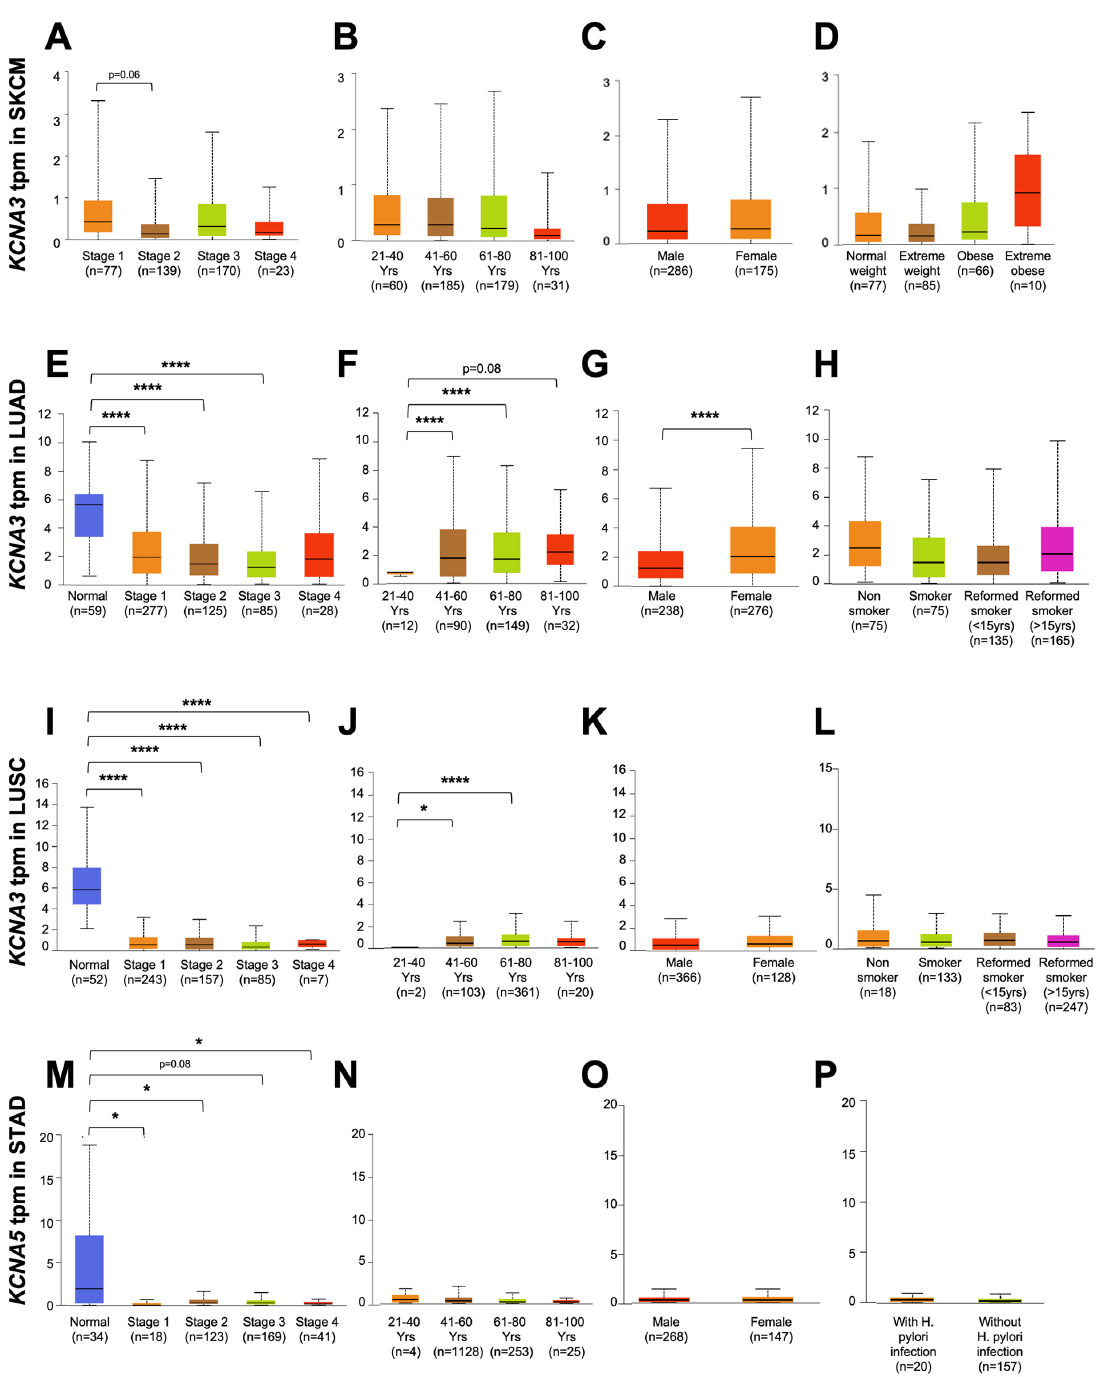
Figure 3. Clinical characterization and prognostic value of KCNAs in cancer. Boxplots represent the relationship between KCNAs mRNA expression with tumor staging ( A , E , I , M ), age ( B , F , J , N ), sex ( C , G , K , O ), and distinct risk factors [i.e., BMI ( D ), tobacco consumption ( H,L ), and h. pylori infection ( P )] in patients affected by different cancer types, using the TCGA databases on UALCAN. Data were normalized as transcripts per kilobase million (tpm). The considered ion channels and cancer-types are reported on the Y-axis. Statistical significance was calculated using t-tests and are specified with asterisks (* p < 0.05, **** p < 0.0001). Data were shown as the mean ± standard deviation. Error bars represented